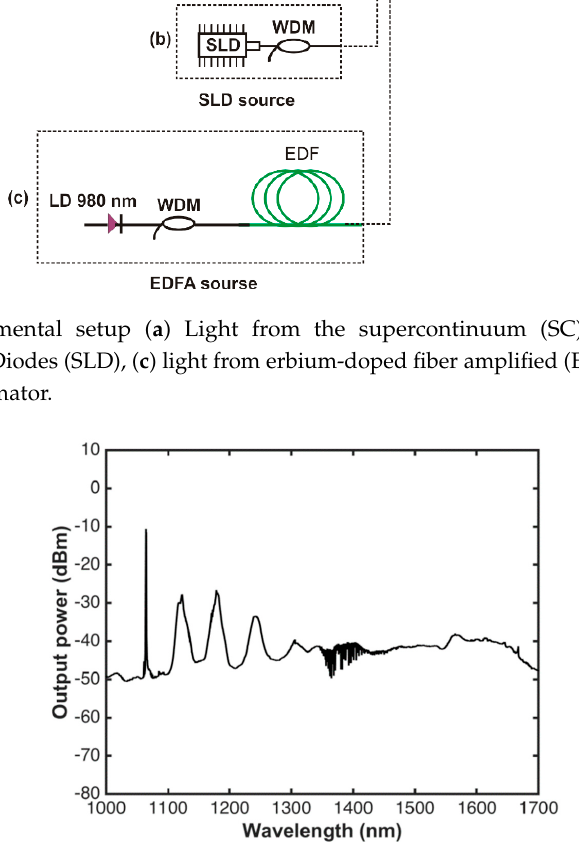
Figure 2. Spectral profile of the supercontinuum radiation.